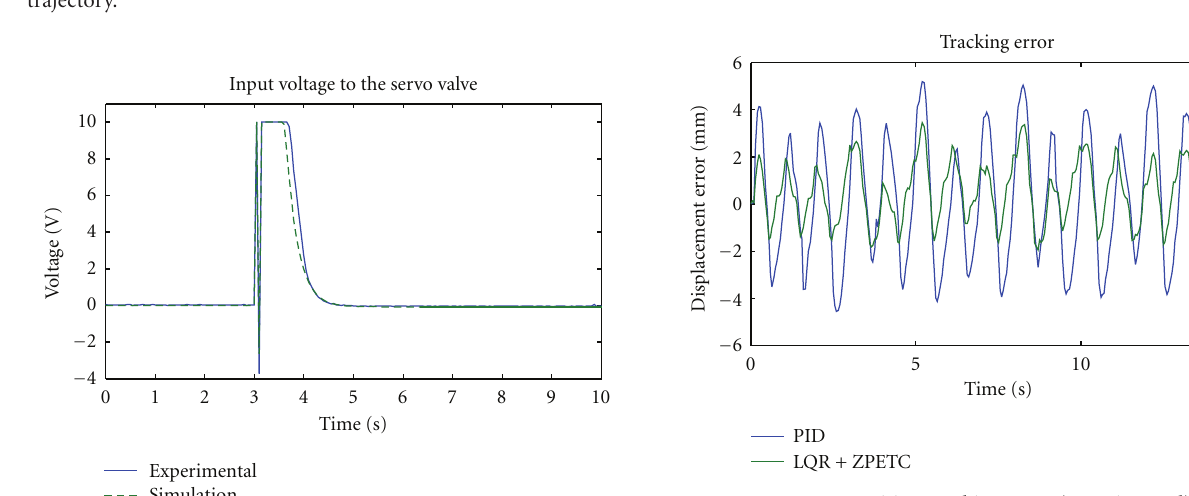
Figure 12: Position tracking error